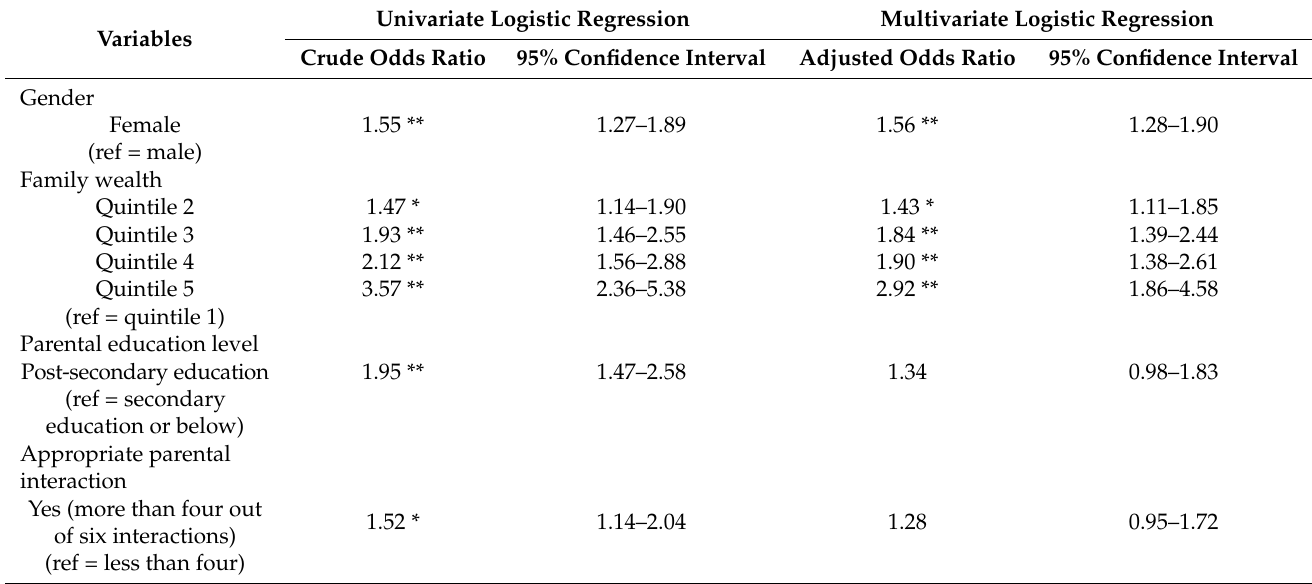
Table 3. Univariate and multivariate logistic regression analysis of achieving appropriate ECD